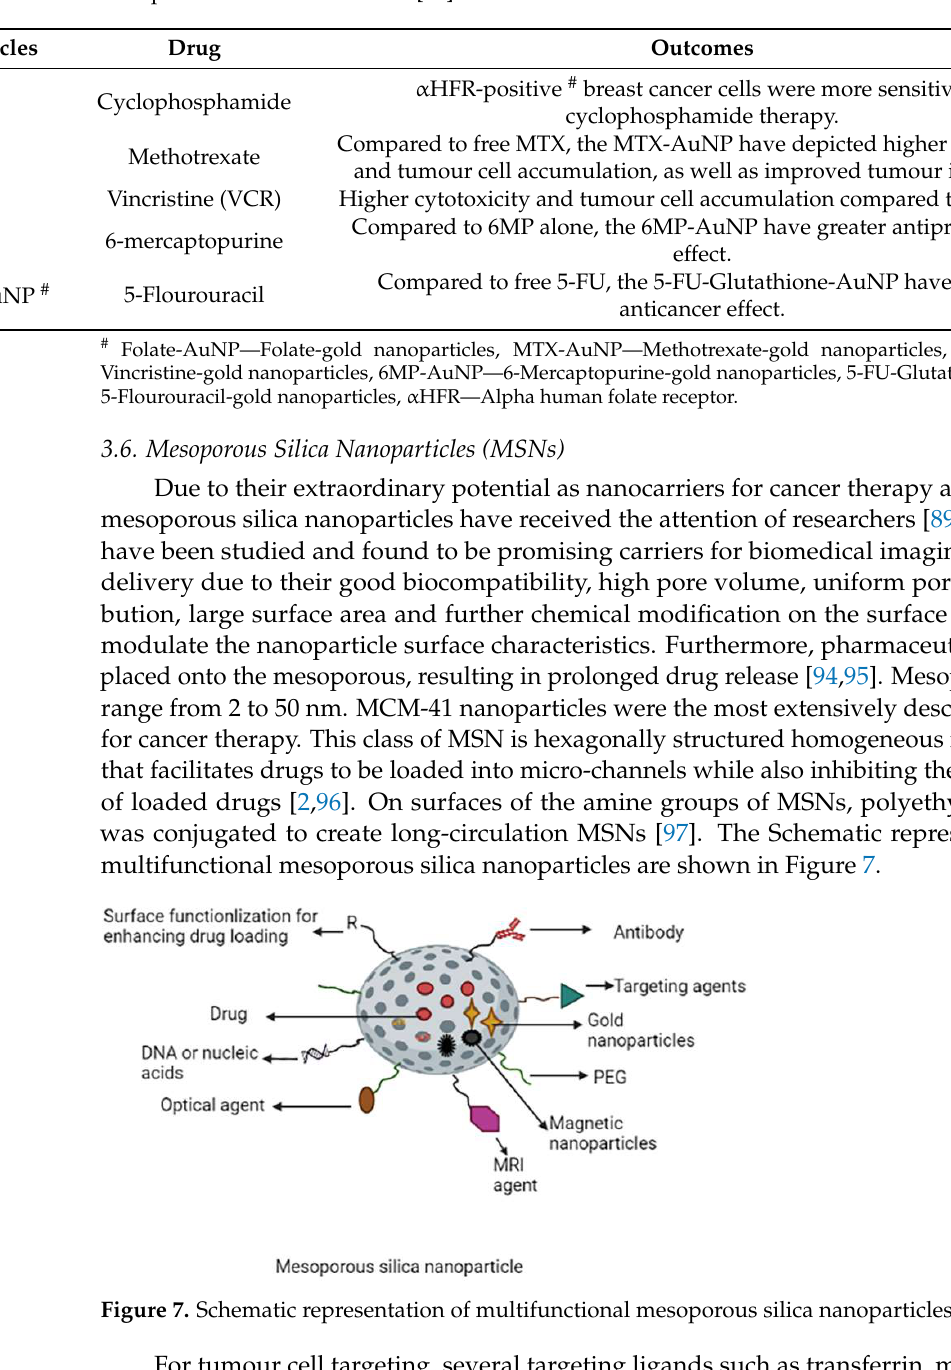
Table 5. Applications of gold nanoparticles (AuNPs) in drug delivery for cancer therapy. Reproduced with permission from reference [88].